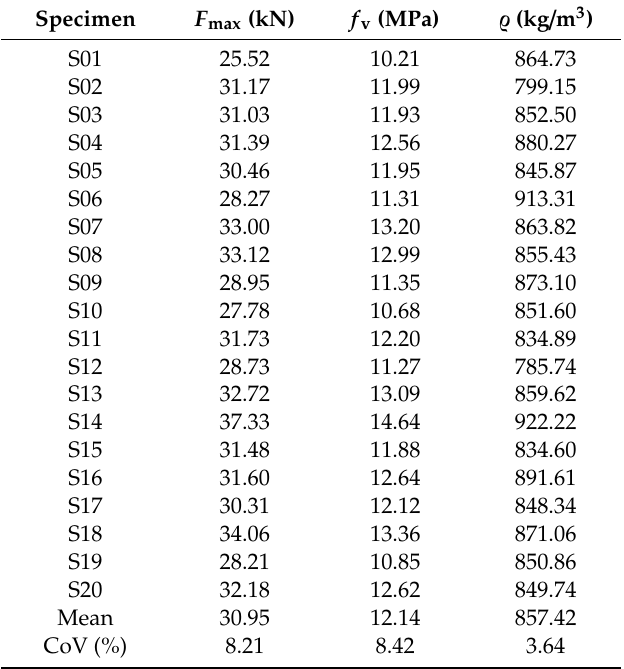
Table 2. Tests results obtained for the eucalyptus shear strength ( f v ).